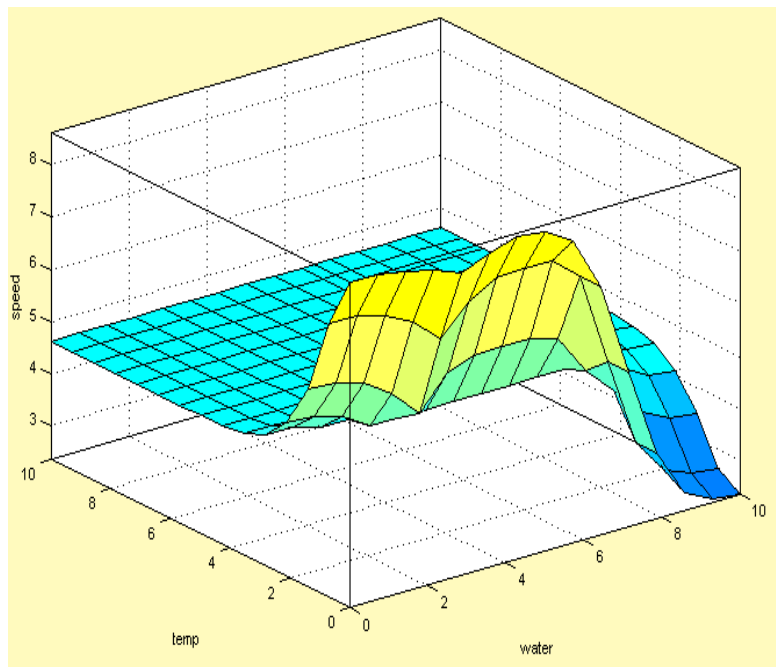
Figure 7. Rules for driving speed on the road.